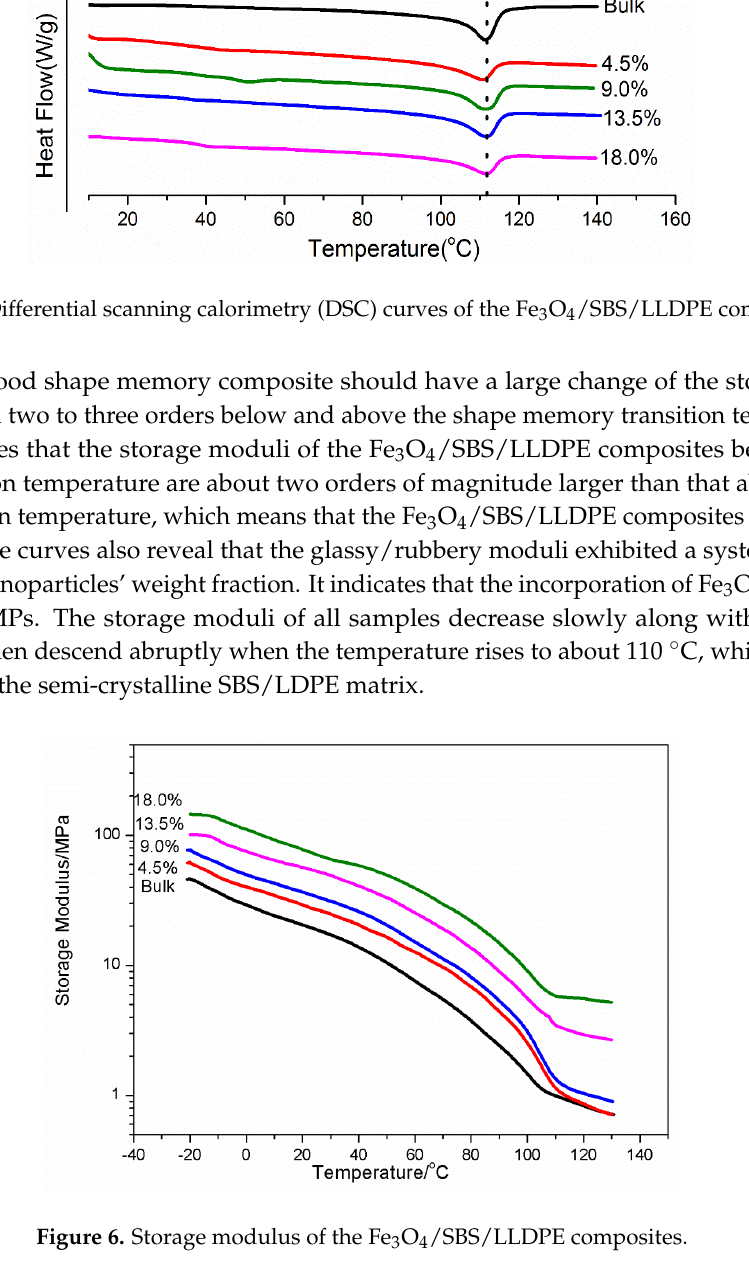
Figure 6. Storage modulus of the Fe 3 O 4 /SBS/LLDPE composites.